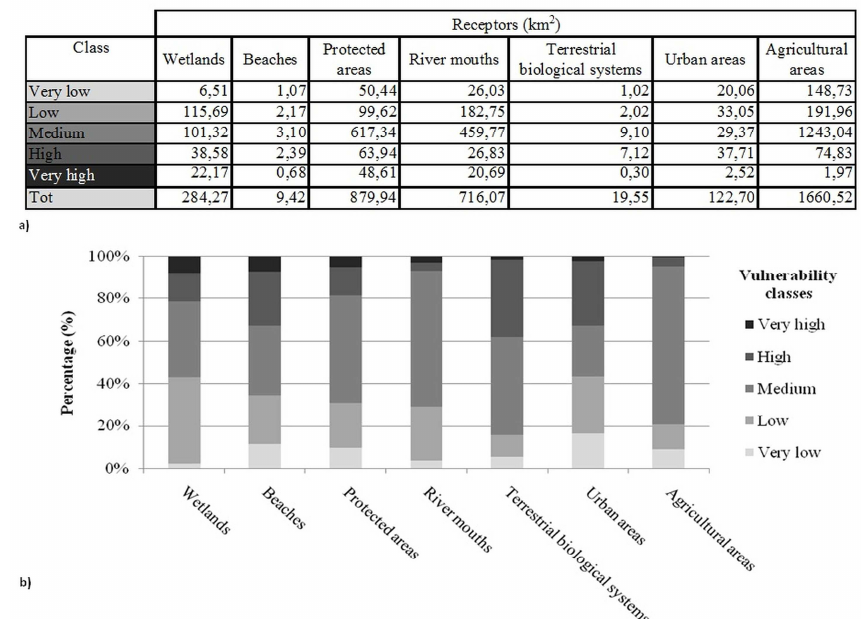
Fig. 4. Distribution of the territorial surface (km 2 ) (a) and of the percentage of surface (b) associated with each vulnerability class for the receptors located on the North Adriatic coast for the sea level rise inundation impact.